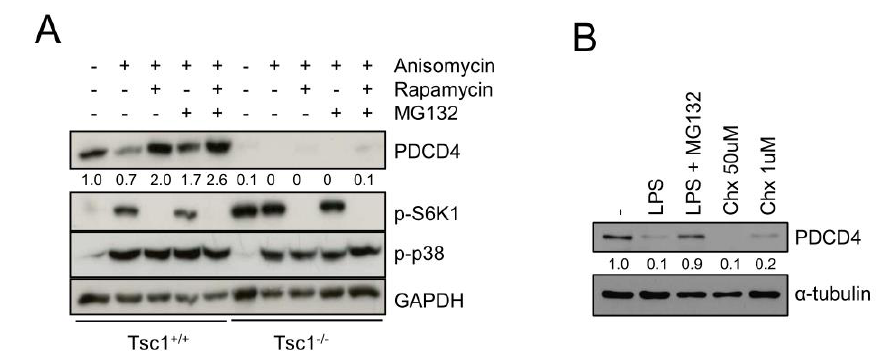
FIGURE 3: Reduction of PDCD4 is caused by p38-stimulated pro- teasome degradation. (A) Tsc1 +/+ and Tsc1 -/- fibroblasts were serum- starved overnight prior to treat- ment with the indicated inhibitors for 90 minutes and subsequent Aniso stimulation for 4 hours. (B) BMDMs were treated with MG-132, LPS or cycloheximide (Chx) as indi- cated for 4 hours. Immunoblots were analyzed as